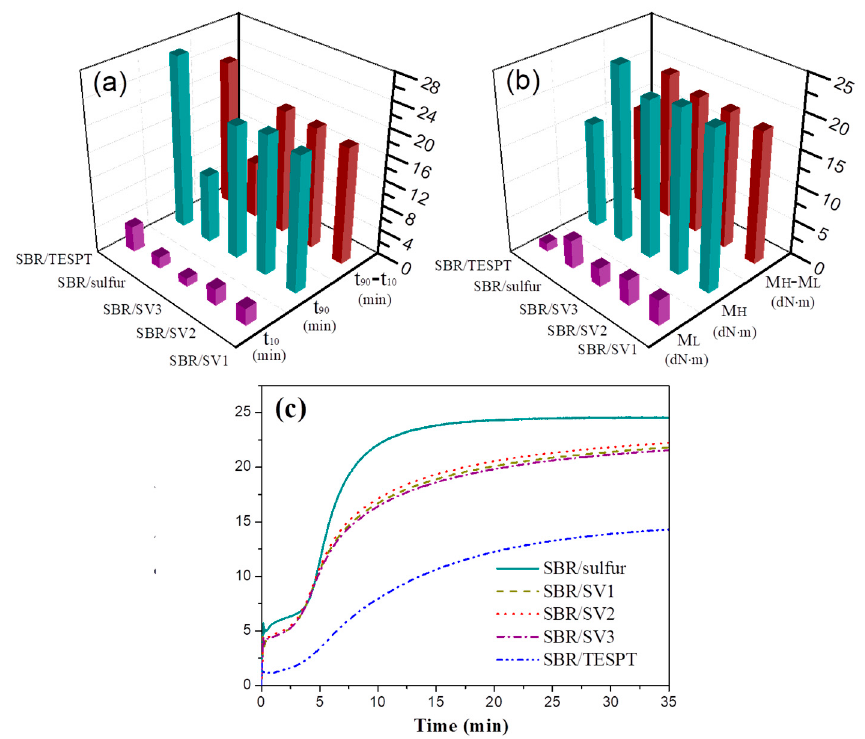
Figure 3. Curing parameters of SBR/sulfur, SBR/TESPT, and SBR/silica-s-VA7 nanocomposites: ( a ) time at 10% of curing degree (t 10 ), optimum cure time (t 90 ), and t 90 -t 10 ; ( b ) minimum torque (M L ), maximum torque (M H ), and M H -M L ; and ( c ) curing curves of SBR/silica nanocomposites.